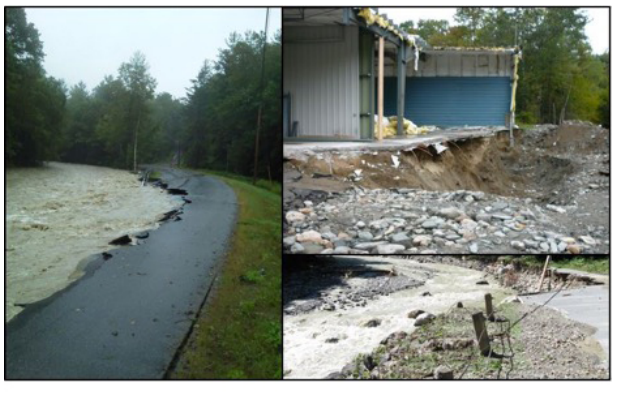
Fig. 2 . Flood impacts along the Chickley River during and after Tropical Storm Irene. The picture on the left shows road damage during Tropical Storm Irene. The picture in the upper right shows municipal building damage in Hawley after the storm. The picture in the lower right shows damage along the Chickley River after the storm.